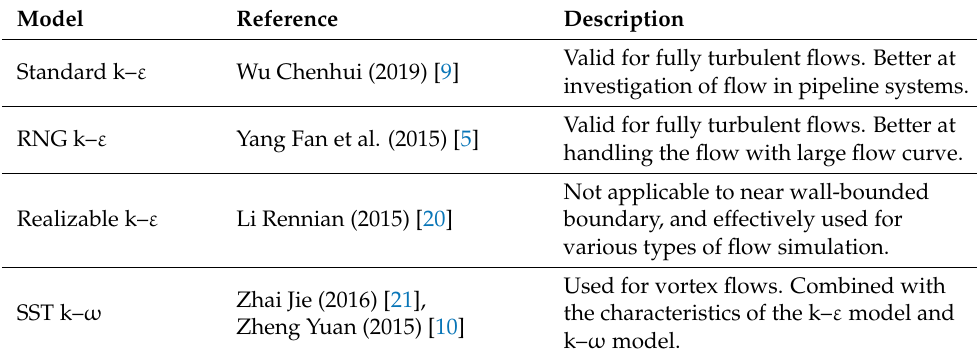
Table 2. Comparison of different turbulence models.